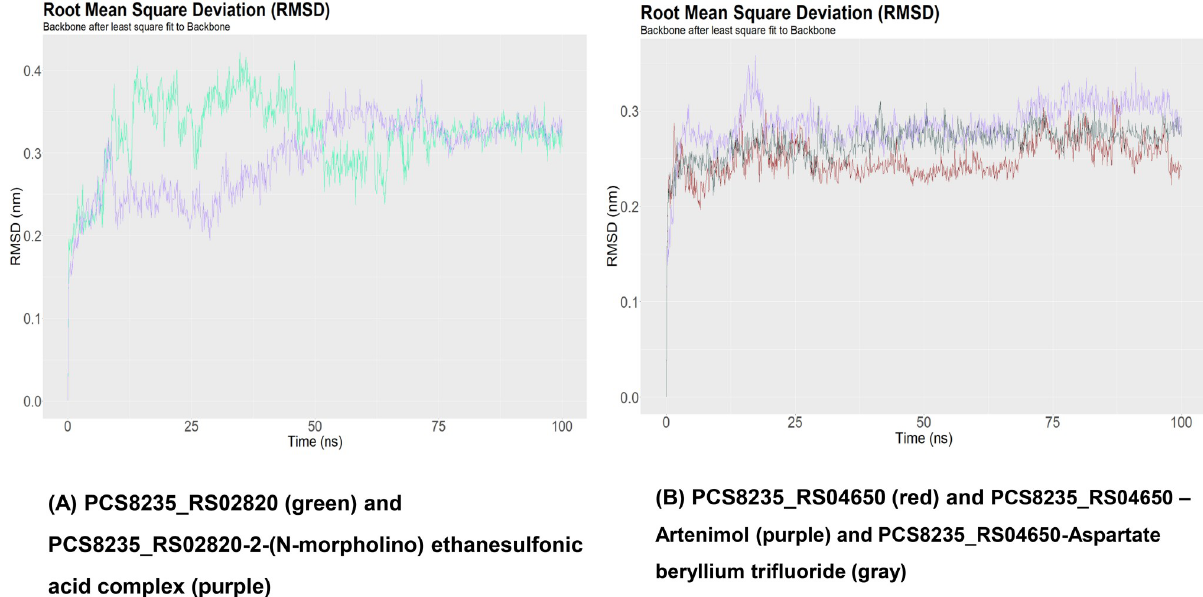
Fig 7. RMSD analysis of (A) PCS8235_RS02820 (green) and PCS8235_RS02820-2-(N-morpholino) ethanesulfonic acid complex (purple) (B) PCS8235_RS04650 (red) and PCS8235_RS04650 –Artenimol (purple) and PCS8235_RS04650-Aspartate beryllium trifluoride (gray) at 100ns.